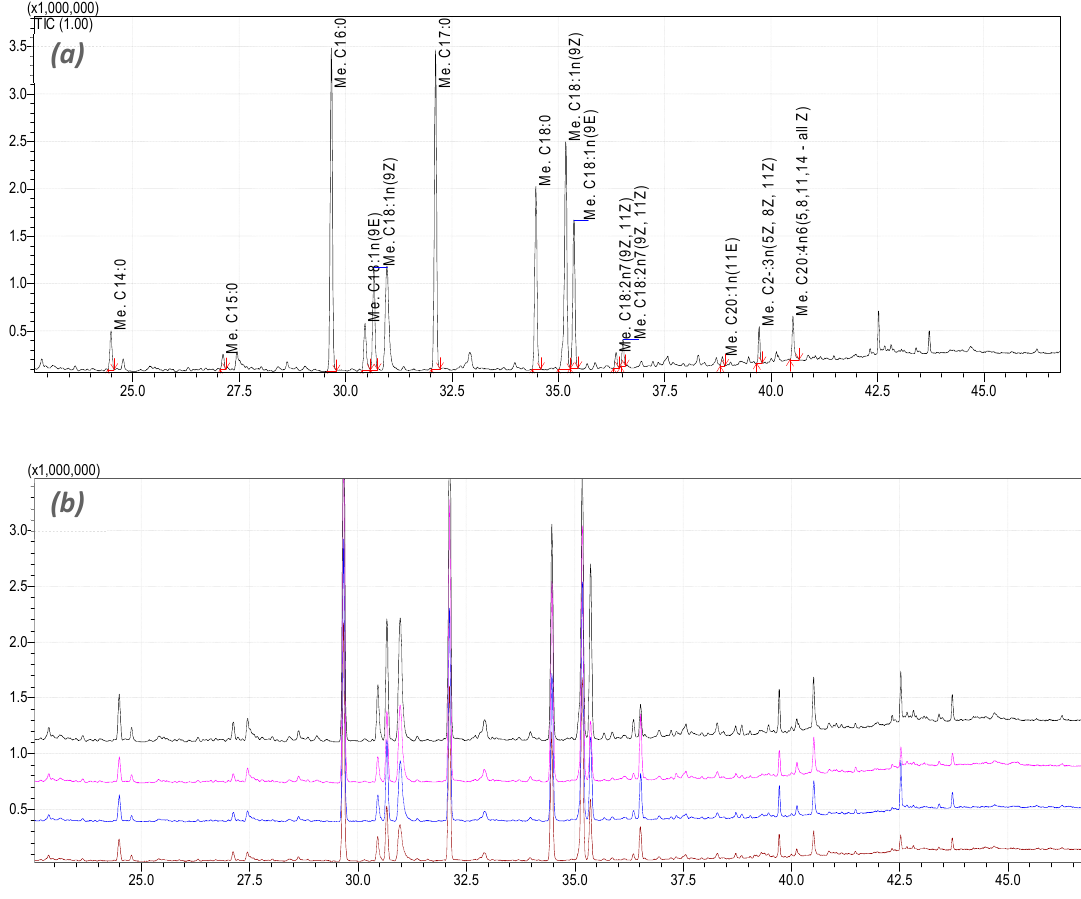
Figure 7. Gas chromatography–mass spectrometry (GC-MS) chromatograms for HepG2 lipidomic analysis. ( a ) Representative standard picks for each identified FFA. ( b ) The black signal indicates HepG2_HE: HepG2 healthy untreated cells; the pink signal indicates HepG2_FFAs: HepG2 cells exposed to the palmitate/oleate combination; the blue signal indicates HepG2_MSI-1436: HepG2 cells pre-treated with 1 µM MSI-1436 inhibitor and exposed to the palmitate/oleate combination; the brown signal indicates HepG2_Comp 23: HepG2 cells pre-treated with 1 µM compound 23 inhibitor and exposed to the palmitate/oleate combination.